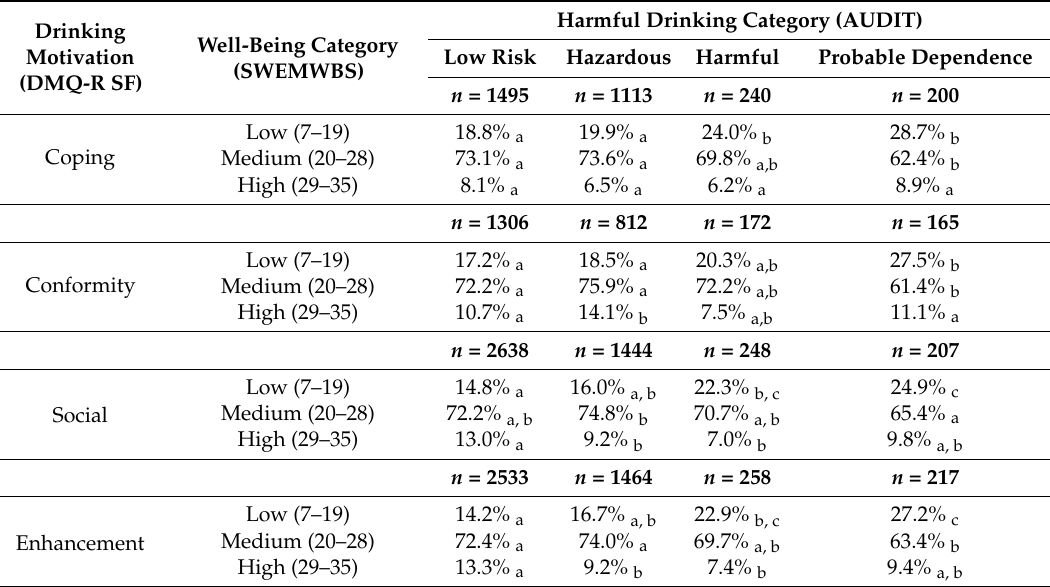
Table 6. Proportion of drinkers split by drinking motivations and harmful drinking category that fall into each wellbeing category (un-weighted bases